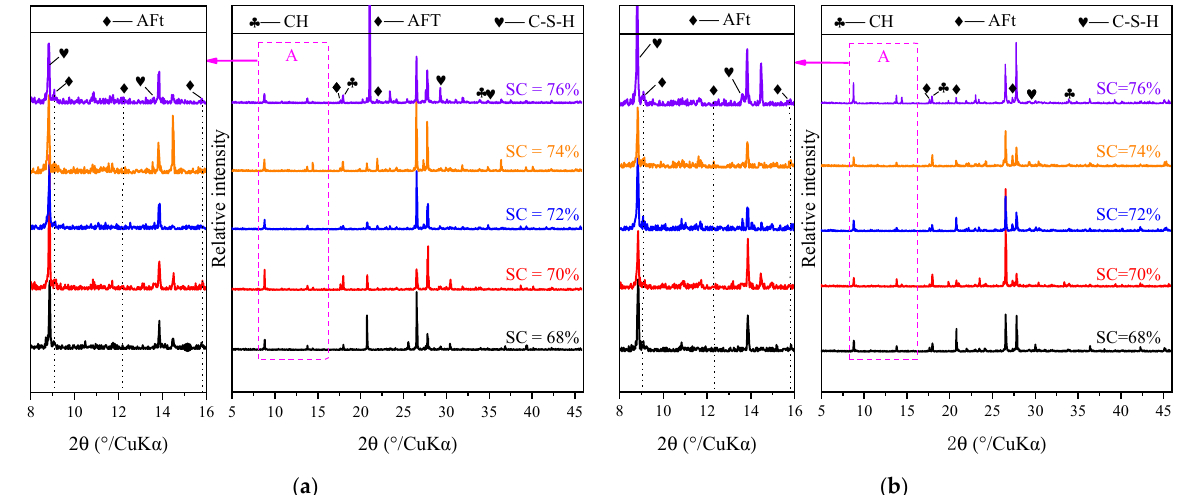
Figure 11. XRD patterns of CSTB in 3 d ( a ) and 7 d ( b ) under TCR = 4.